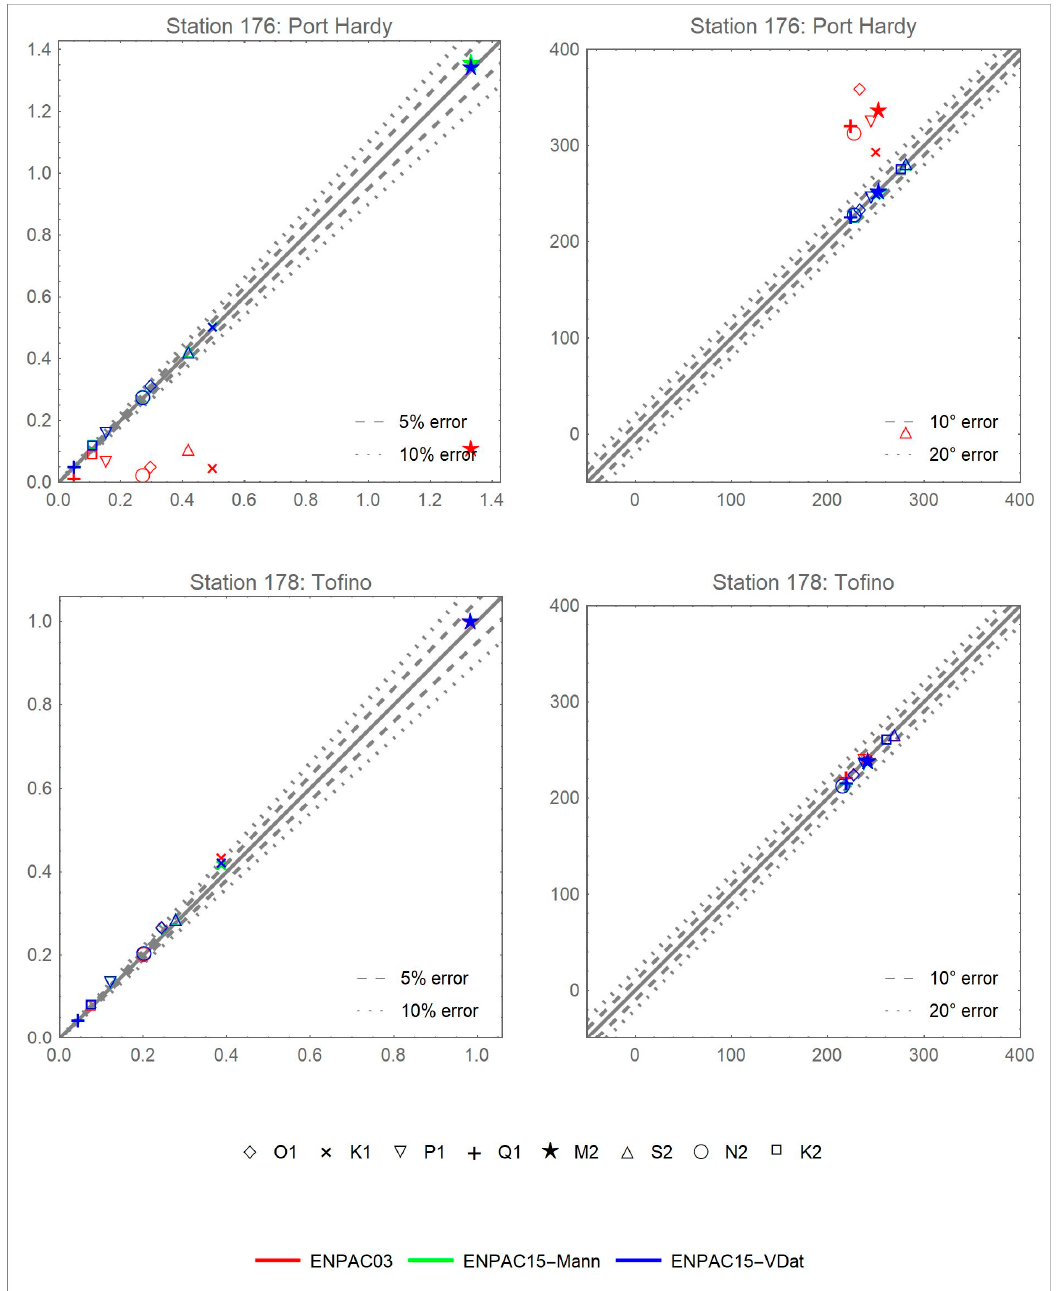
Figure A11. Scatterplots of errors for two British Columbia stations, locations shown in Figure A4.